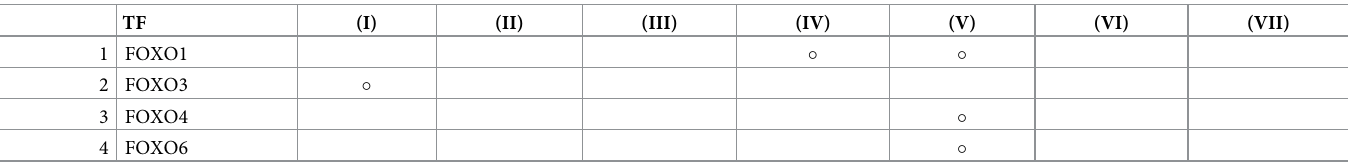
Table 7. Identification of FOXO transcription factor (TF) family members within seven TF-related categories in Enrichr. Roman numerals correspond to the first col- umn in Table 3. TF